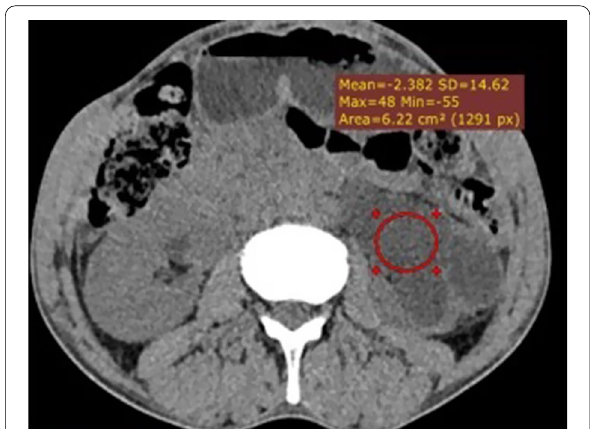
Fig. 3 Axial CT scan showing marked dilatation of the left PCS with thinning out of the renal parenchyma. Mean HU within the dilated pelvicalyceal system -2.3 HU indicating the diagnosis of = hydronephrosis